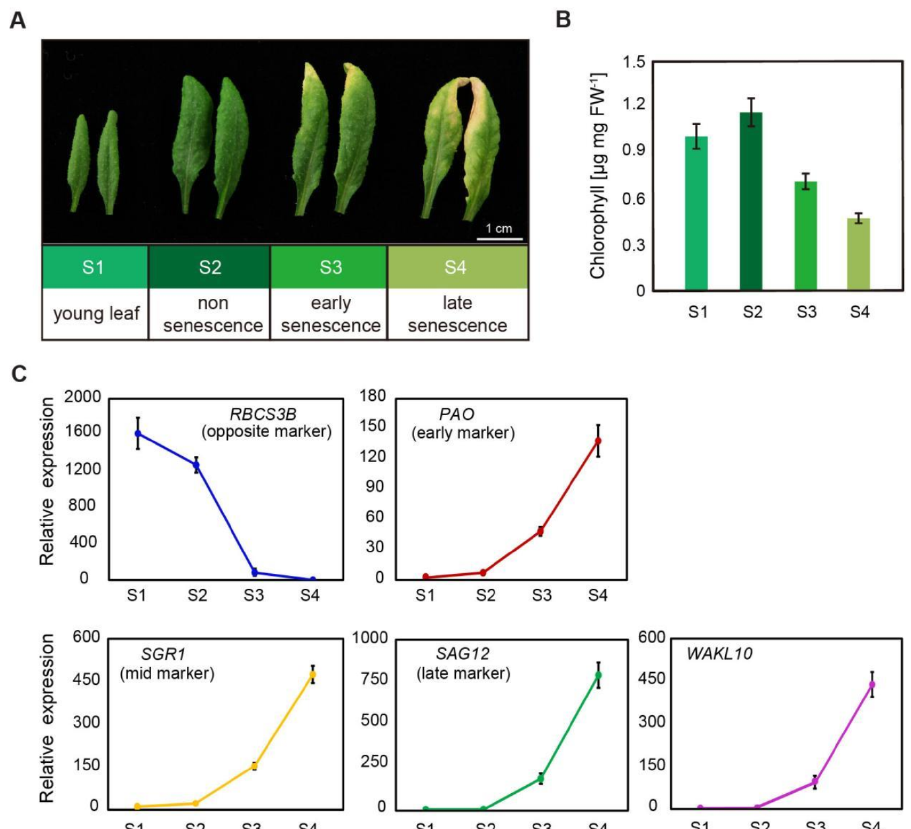
Figure 2. The specifically upregulated expression of AtWAKL10 in leaves of A. thaliana wild type (Col-0) plants during natural senescence. ( A ) Representative images of fifth and sixth rosette leaves from A. thaliana wild type (Col-0) plants at different developmental stages. S1, young leaf; S2, non- senescence leaves with true leaves fully expanded; S3, early senescent leaf with yellowing leaf area less than 25% from the leaf tip; S4, more than 40% of leaf area yellowing. ( B ) The chlorophyll concentrations in leaves 5 and 6 at S1, S2, S3, and S4 stages. ( C ) The transcript abundance of AtWAKL10 and leaf senescence marker genes. Data were given as averages ± SE of three biological replicates. For RBCS3B , gene expression was calculated relative to S4 stage, or otherwise, was relative to S1